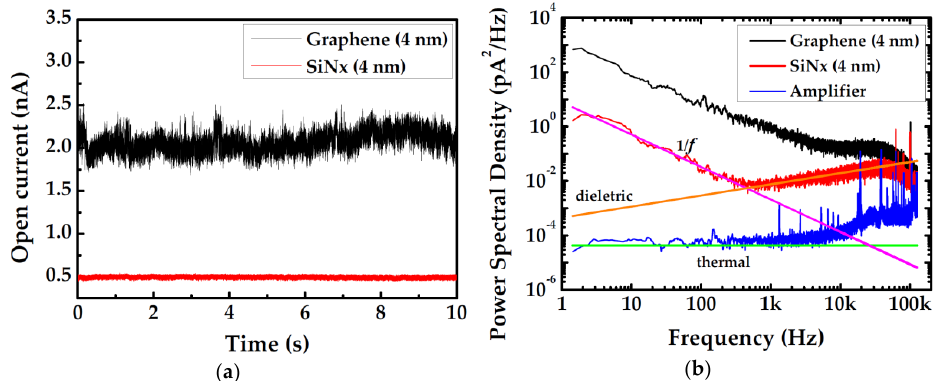
Figure 1. Comparison of noise level in different material nanopore systems measured at 1 M KCl and 100 mV: ( a ) Open current of two comparable nanopores punched on graphene and SiN x , respectively; and ( b ) noise power spectral densities of the two nanopores. The fitting executed according to the